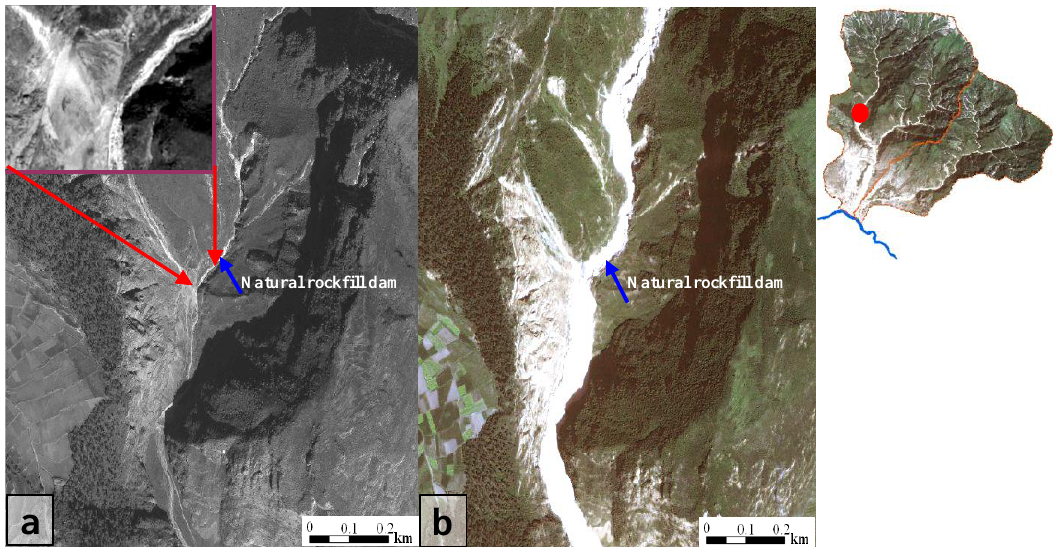
Fig. 6. Imagery showing erosive features of the debris flow channel and hillslope failures in colluvial deposits in the transport zone of the Sanyangyu catchment after the rainstorm event. The breaching of a significant natural rockfill dam resulted in intensive channel erosion and an instant increase in the flow discharge.